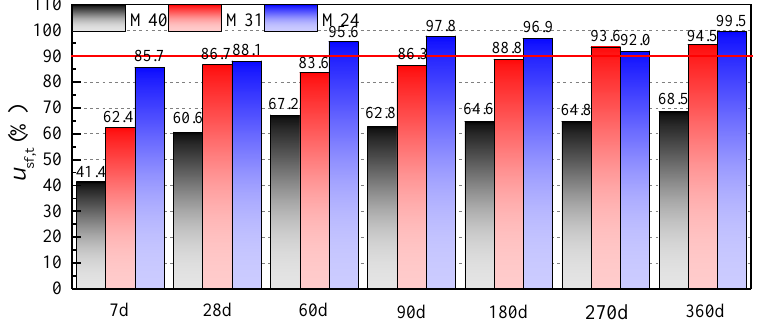
Figure 9. The u sf,t of steel fibers in M40, M31 and M24.